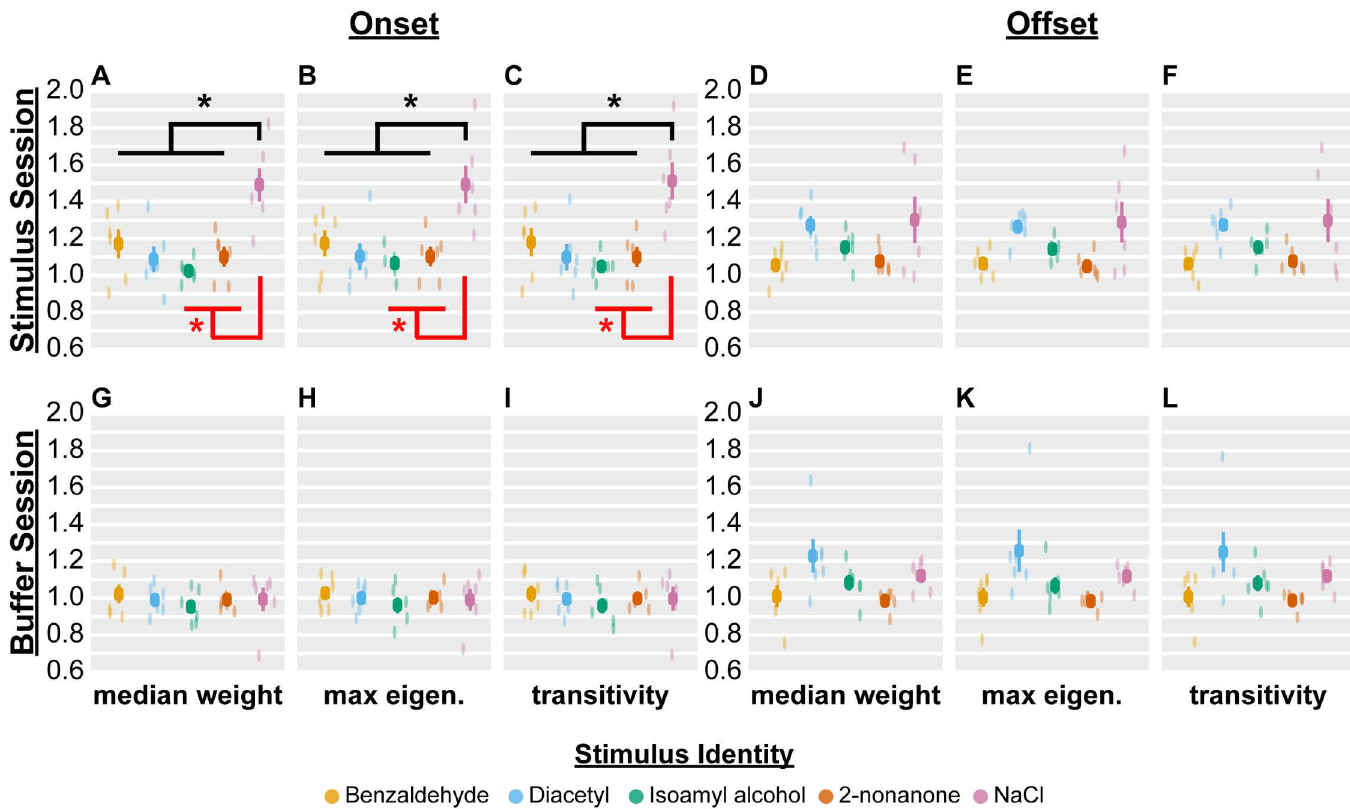
Fig 4. Neural network graph features differ between NaCl and the odorants isoamyl alcohol and 2-nonanone on stimulus onset. “Median weight” refers to the change in median entry of adjacency matrix, “max eigen.” refers to the change in its max eigenvalue, and “transitivity” to the change in its weighted number of triangles (i.e., triplets of neurons interacting with each other) relative to baseline. All three features are modulated by stimulus identity on stimulus onset (A, B, C), but not offset (D, E, F); they are also not modulated by the addition (G, H, I) or removal (J, K, L) of M9 buffer. Each color dot is the mean value across all seven pulses for a single worm, and the dark squares and lines indicate the mean and standard error of the mean across all worms (n = 6 worms per stimulus). p > 0.05 for all comparisons after Bonferroni correction with effective number of variables meff = 27.1, except panels A—C (black � , p = 2.5e-4, 7.4e-4, and 3.9e-4). Furthermore, p < 0.05 after Bonferroni correction with meff = 6.2 for panels A—C in Data Set 2 (red � , p = 5.4e-3, 7.7e-3, and 6.9e-3). We used the likelihood ratio test on full and null generalized linear-mixed effects models (GLMEs), where the former included stimulus identity as a fixed effect, to compute the aforementioned p-values. We then used pairwise F-tests for both Data Set 1 and 2 on the stimulus coefficients of the full GLME to compute pairwise significance at p < 0.05, which is indicated by black � for Data Set 1, � for Data Set 2, and the bar connecting NaCl and the rest of chemicals in panels A—C. The F-tests used Bonferonni correction based on the total number of distinct pairwise comparisons (i.e., alpha = 0.05/10 for Data Set 1, and 0.05/3 for Data Set 2). Together, the asterisks indicate that the NaCl-induced network differs from the network induced by isoamyl alcohol and 2-nonanone in both data sets. Though NaCl also induced larger feature values than diacetyl in Data Set 1 ( black � in A—C), this could not be tested in Data Set 2 (lack of red � in A—C), which lacks diacetyl